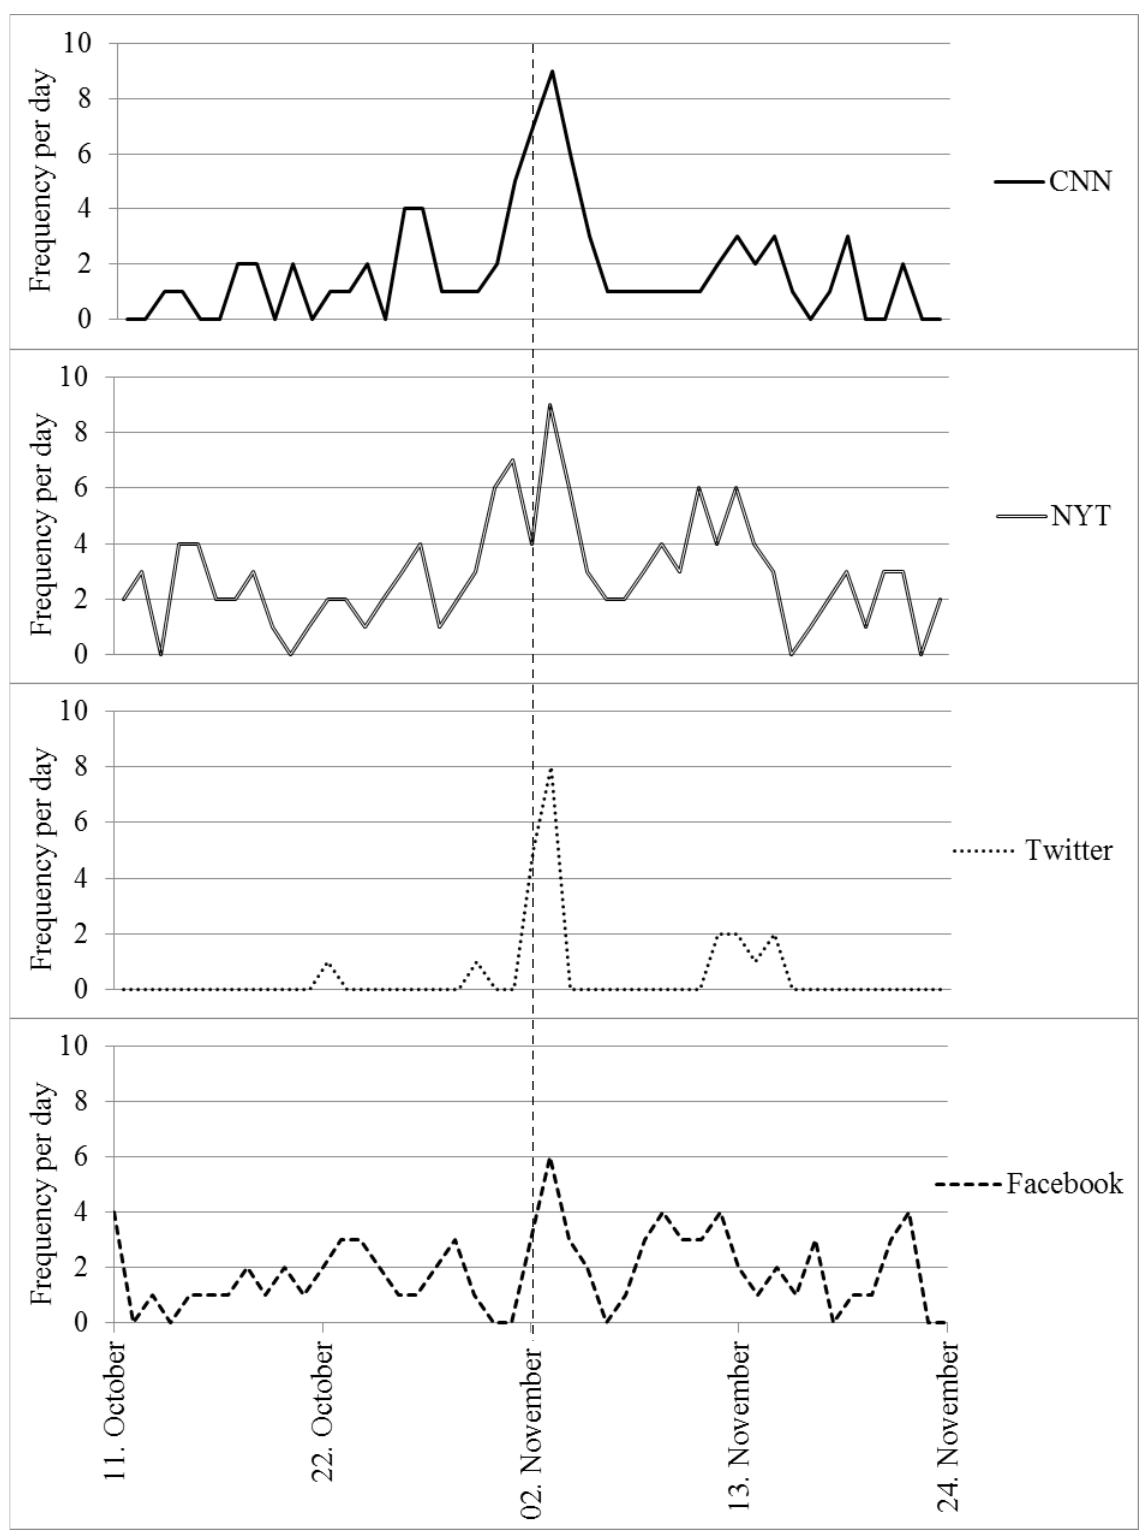
Figure 1. Political coverage over time across traditional media and social networking sites. Note: 2 November was the date of the 2010 US Midterm